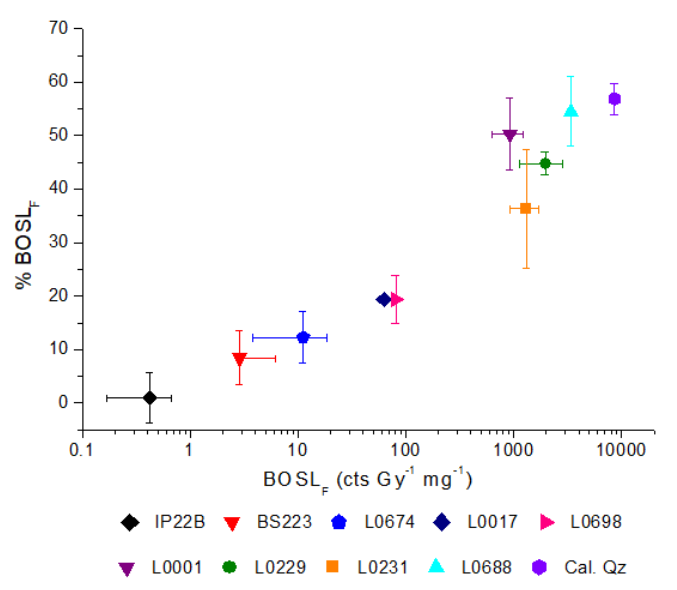
Figure 2. Quartz OSL sensitivity represented by the percentage of the initial 1 s of light emission (%BOSL F ) compared to the absolute quartz BOSL F sensitivity (normalized by dose and aliquot The BOSL F sensitivity decreases with the increase of preheat temperature, but sensitivity mass). Each sample is represented by the average of three aliquots. Error bars correspond to the differences among samples are not affected by the preheat temperature (Figure 3 and Table 6). standard deviation.